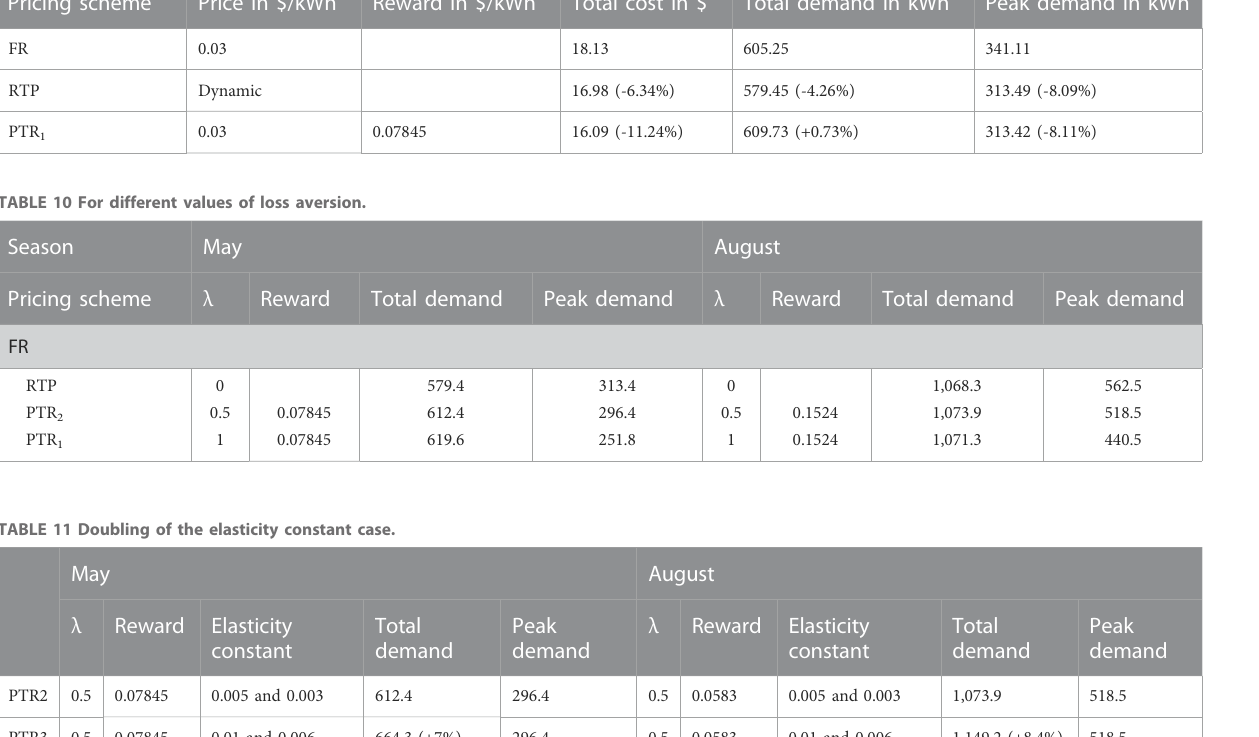
TABLE 9 Peak reduction scenario. Pricing scheme